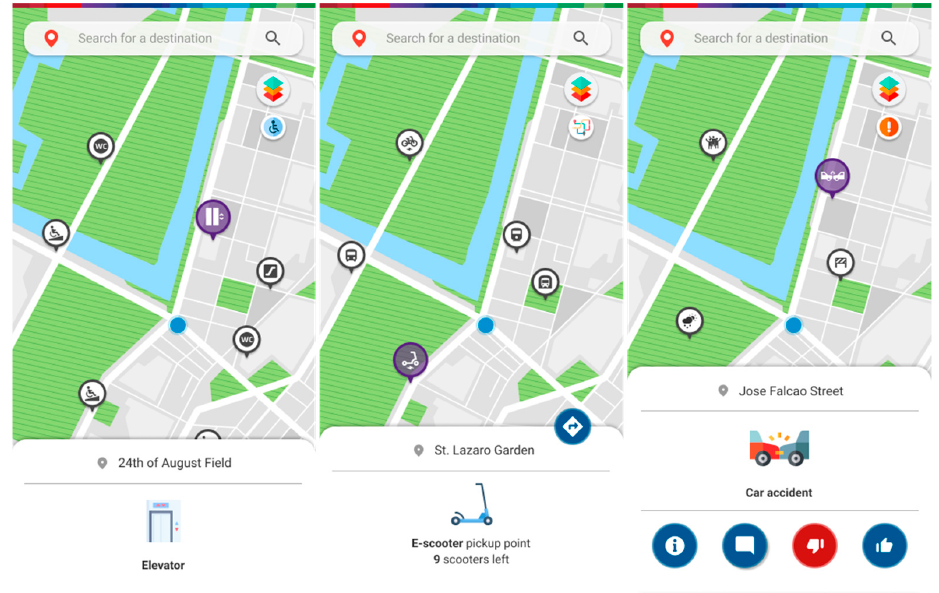
Figure 8. Screens depicting information on the location of elevators, scooter pickup points, and a car accident